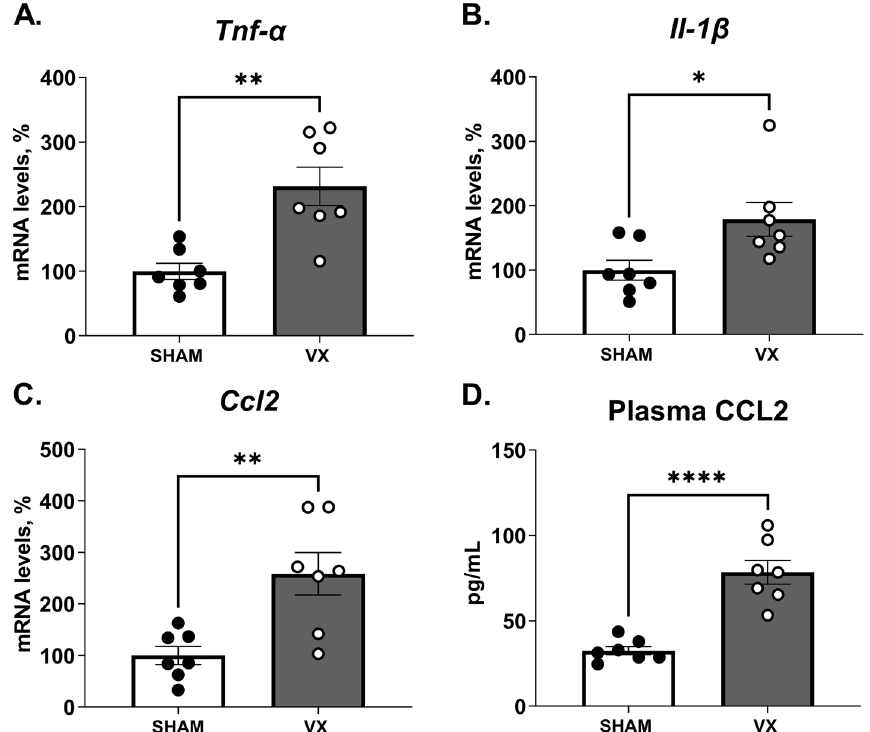
Fig. 2 Elevation of peritonitis-induced pro-inflammatory mediators in liver homogenates and blood from vagotomized mice. Wild-type C57BL/6J mice were subjected to either left cervical vagotomy (VX, grey bars) or sham surgery (SHAM, white bars). After 7 days, mice were injected intraperitoneally with zymosan (0.1 mg/mouse) and euthanized after 12 h. Liver and blood samples were collected and analyzed by qPCR and ELISA. ( A - C ) Transcripts of pro-inflammatory mediators in liver homogenates were measured by qPCR. Bars show mean individual mice. Transcript levels were normalized to Ppia and expressed relative to SHAM (100%). ( D ) Plasma CCL2 was measured by ELISA. n mice per group. Bars show mean SEM, dots represent individual mice. * p < 0.05; ** p < 0.01; *** p < 0.001; **** p < 0.0001. (two-sided Student´s ± t